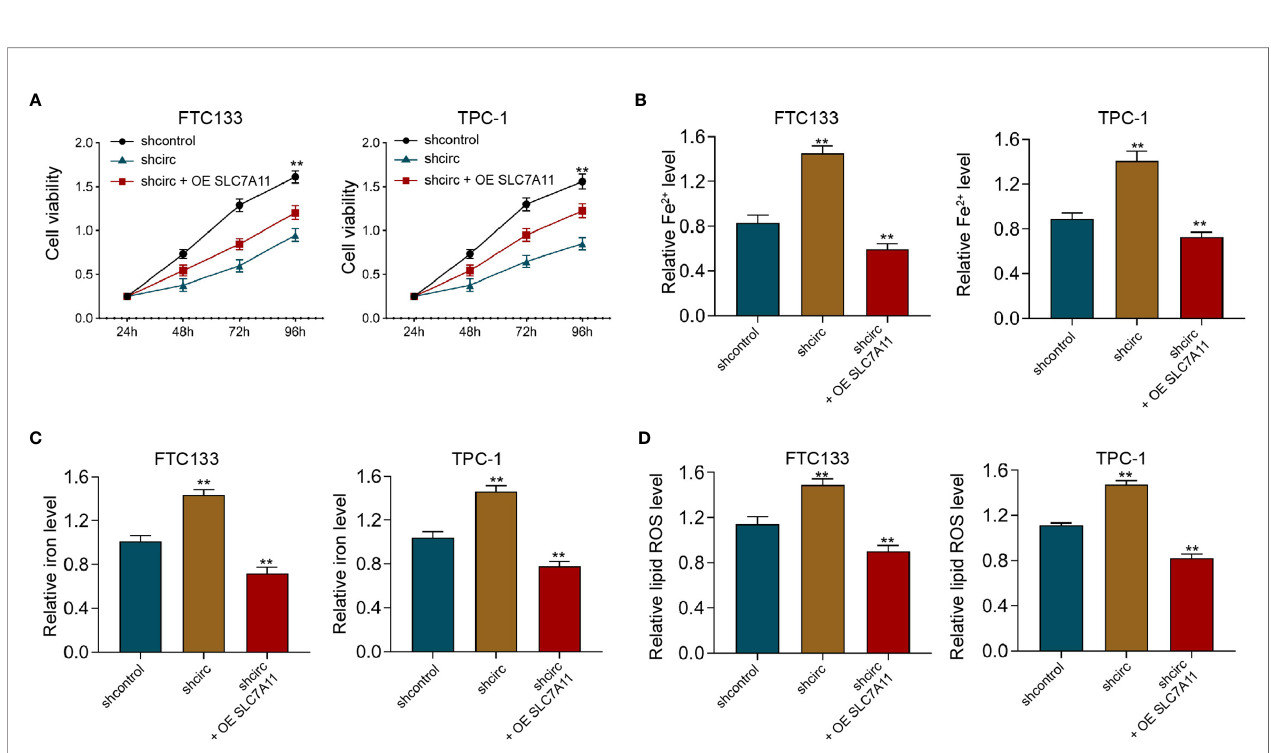
FIGURE 6 | SLC7A11 overexpression reverses miR-545-3p -enhanced ferroptosis of thyroid cancer cells. (A) The analysis of FTC133 and TPC-1 cell viability by MTT assays. (B – D) Analysis of Fe 2+ , iron, and ROS levels in FTC133 and TPC-1 cells. mean ± SD, ** P < 0.01.